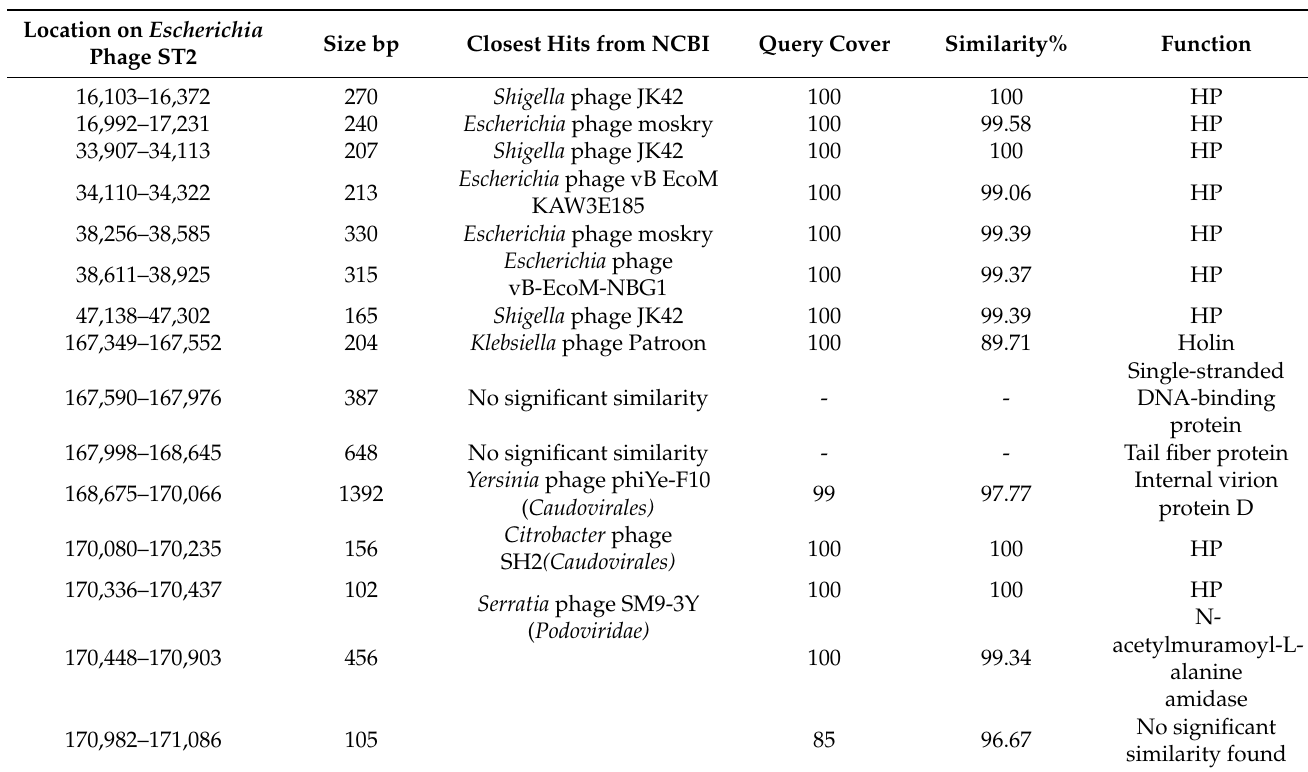
Table 6. Genes occurred in Escherichia phage ST2 and not present in Escherichia phage vB EcomM PhAPEC2.